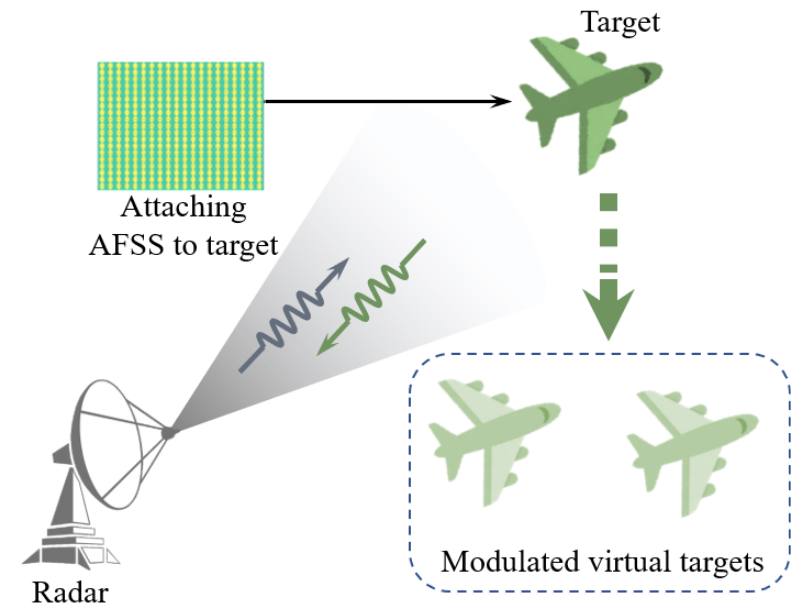
Figure 3. The schematic diagram of ISAR image modulation.